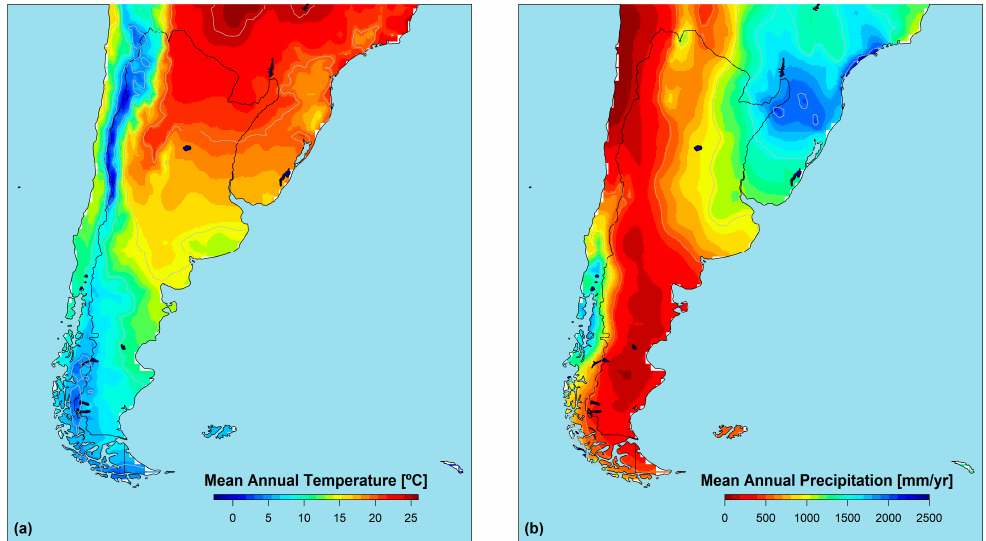
Figure A2. Mean annual temperature ( a ) and mean annual precipitation ( b ) based on CRU v.4.01 dataset.